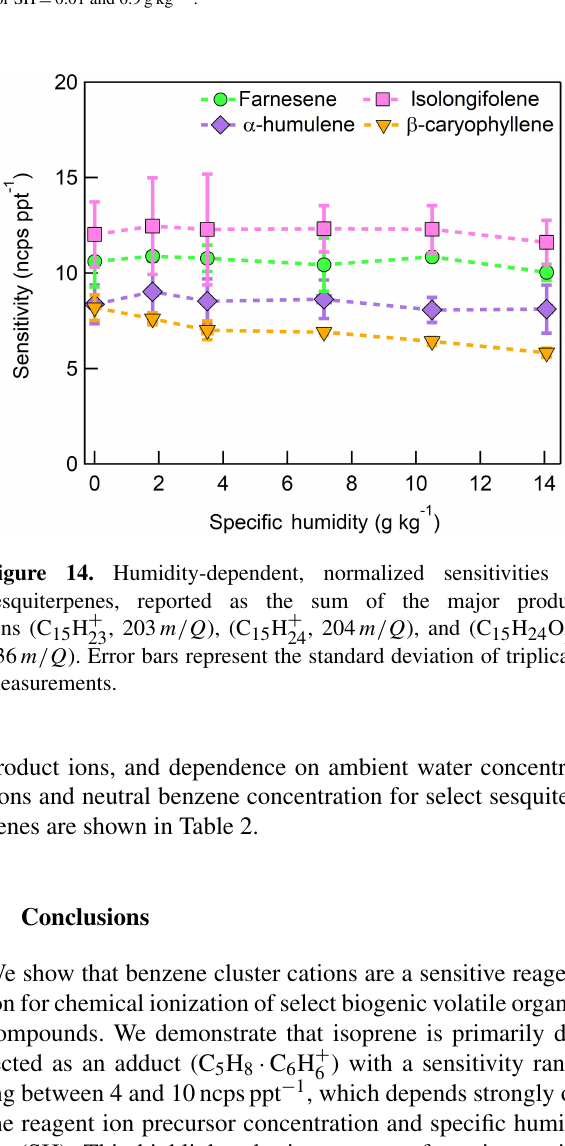
Figure 13. Humidity-dependent, normalized sensitivities to (a) far- nesene and (b) isolongifolene for all major product ions (C 15 H + , 23 203 m/Q , orange squares), (C 15 H + , 204 m/Q , green circles), and 24 (C 15 H 24 O + , 236 m/Q , purple triangles). Error bars represent the 2 standard deviation of the triplicate measurement.